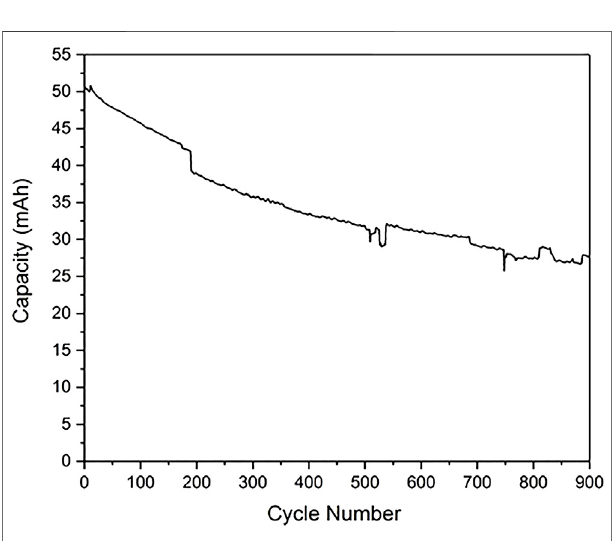
FIGURE 6 | The capacity of a cell cycled between 2.7 and 4.3 V as a function of cycle number. These experiments were conducted over a long period of time, and there were some week-long periods of lab shutdown (notably just before 200 cycles), which lead to some step changes in